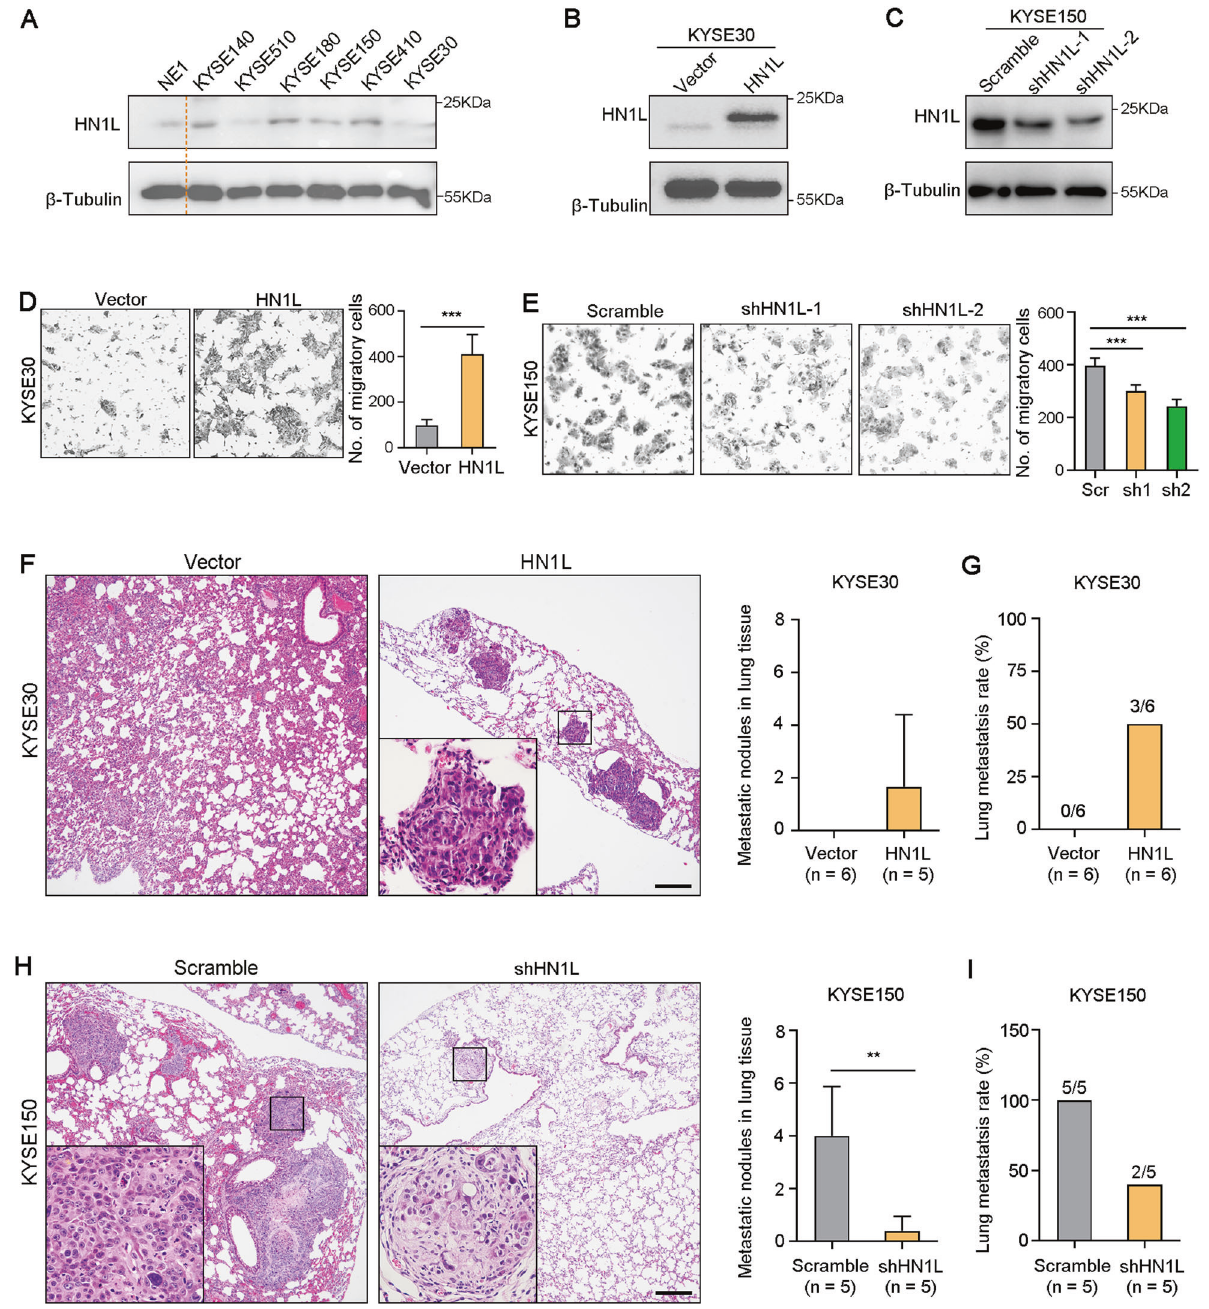
Fig. 2 Elevated HN1L enhances ESCC metastasis. A HN1L expression in normal esophageal epithelial cell NE1 and ESCC cell lines were analyzed by western blotting. B Western blotting was used to con fi rm the exogenous overexpression of HN1L in KYSE30 cells. C Silence of HN1L in KYSE150 cell with shRNA was con fi rmed by western blotting analysis. D Transwell assay using KYSE30-Vector and KYSE30- HN1L cells. E Transwell assay with KYSE150-scramble and KYSE150-sh HN1L cells. F Lung metastasis of KYSE30-Vector and KYSE30- HN1L cells were tested by tail vein injection in nude mice and H&E staining of lung tissues was performed. Scale bar, 250 μ m. G The rate of mice with lung metastasis was counted. H H&E staining of lung tissues from nude mice after tail vein injection of KYSE150-scramble and KYSE150-sh HN1L cells. Scale bar, 250 μ m. I The rate of mice with lung metastasis was counted. In all panels, data are presented as the mean ± SD; two-sided Student ’ s t test; ** P < 0.01, *** P < expression increased the level of Docetaxel-induced apoptosis (Fig. of Docetaxel in vivo (Fig. 4C). Inversely, knockdown of HN1L 4E, F). In addition, overexpression HN1L in KYSE30 cell also reduced inhibited tumor growth and enhanced the sensitivity of KYSE150 the anti-tumor activity of Cisplatin in vivo (Fig. S4A). In contrast, cells to Docetaxel (Fig. 4D). The level of apoptotic cells in xenograft knockdown of HN1L improved the sensitivity of tumor cells to tumors was analyzed by IHC staining with antibodies against Cisplatin (Fig. S4B). Hence, targeting HN1L enhanced the anti-tumor Cleaved Caspase 3. Overexpression HN1L decreased the apoptosis effect of chemotherapeutic drugs. level of ESCC cells under treatment of Docetaxel, and reducing HN1L